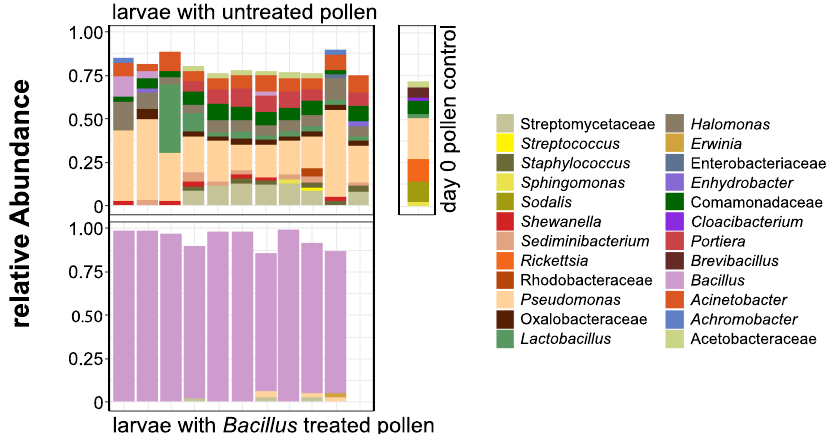
Figure 6. Bacterial composition of larvae which fed for five days on untreated pollen taken from one O. bicornis nest ( top left ), of the original fed pollen day 0 control ( top right ), and of larvae which fed for up to five days on pollen inoculated with one Bacillus sp. strain ( bottom ). Agglomerated up to genus level or family level if not better classifiable.